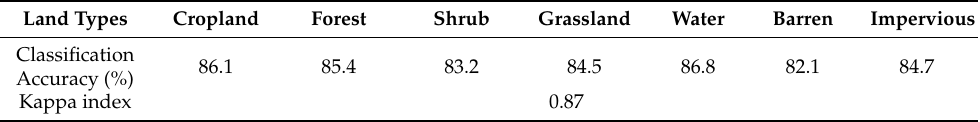
Table 1. Image classification accuracy and Kappa